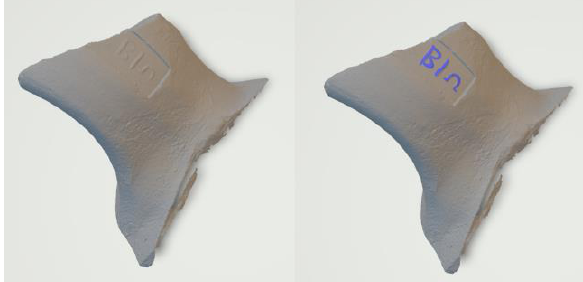
Figure 3 : 3D survey and highlighting of stamp (TRE)BI  , No.85.